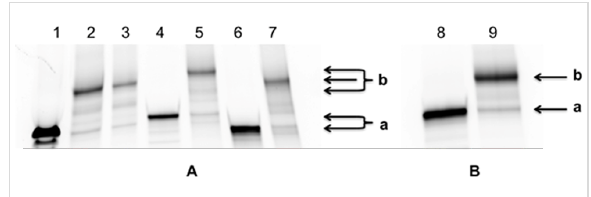
Figure 14: Electrophoresis analysis of reaction mixtures in 20% dena- turing polyacrylamide gel after TINA-TFO-MGB conjugation (visualiza- tion by TINA fluorescence). A) Conjugates 26 (lanes 2 and 3), 27 (lane 5), 29 (lane 7). Lanes 1, 4 and 6 are control oligonucleotides 20 , 21 and 22 , respectively B) Conjugate 28 (lane 9); lane 8 – control oligo- nucleotide 21 . Arrows indicate: a, control oligonucleotides, b, conju-